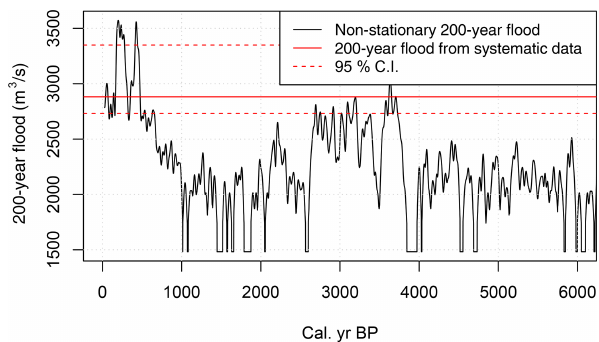
Figure 16. Non-stationary estimate of the 200-year flood for the recent 6000 years. The red lines indicate the estimated 200-year flood and the 95% confidence intervals estimated using systematic streamflow